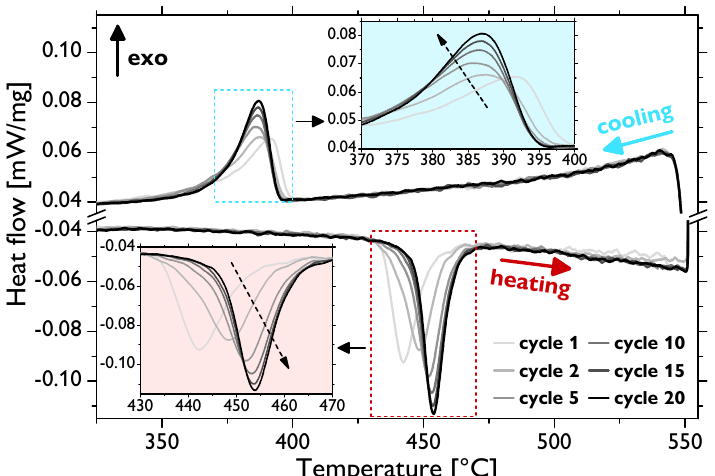
Figure 5. Selected DSC curves of the sample 1000 subjected to thermal cycling of 20